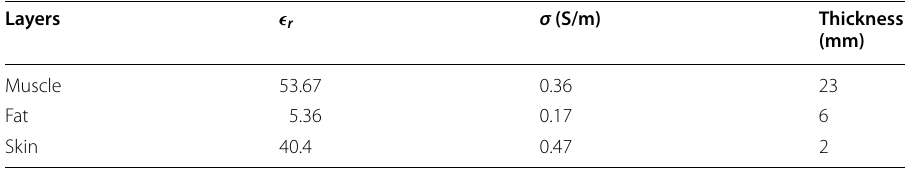
Table 2 Dielectric characteristics of human tissue at 3.6 GHz Layers